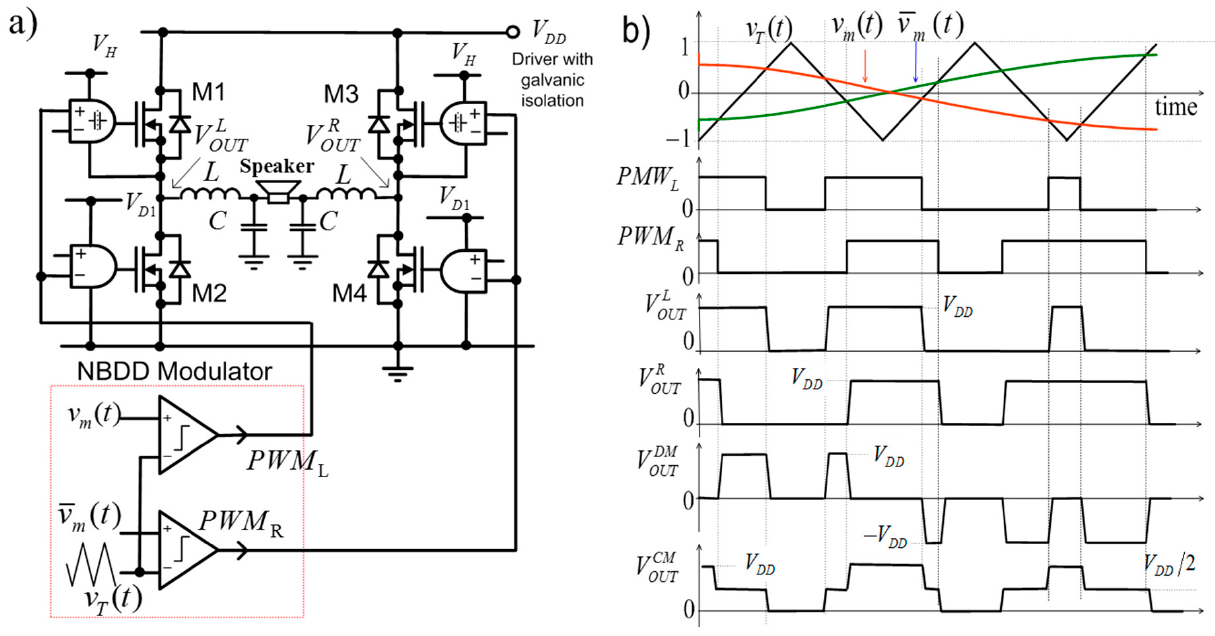
Figure 1. Class ‐ BD amplifier, using NBDD PWM modulator: ( a ) Block diagram; ( b ) time domain waveforms of: NBDD output signals and voltages at DM and CM outputs.